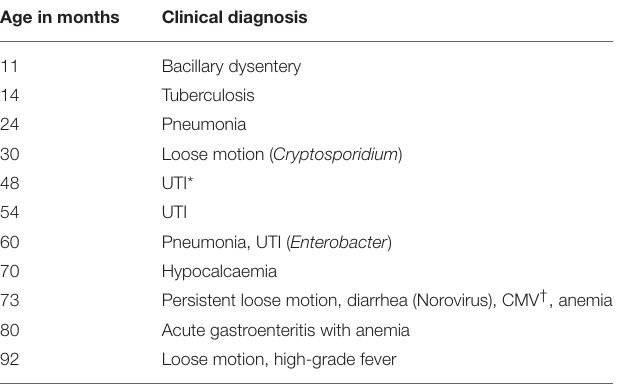
TABLE 1B | Clinical presentations of the SCID patient during hospital